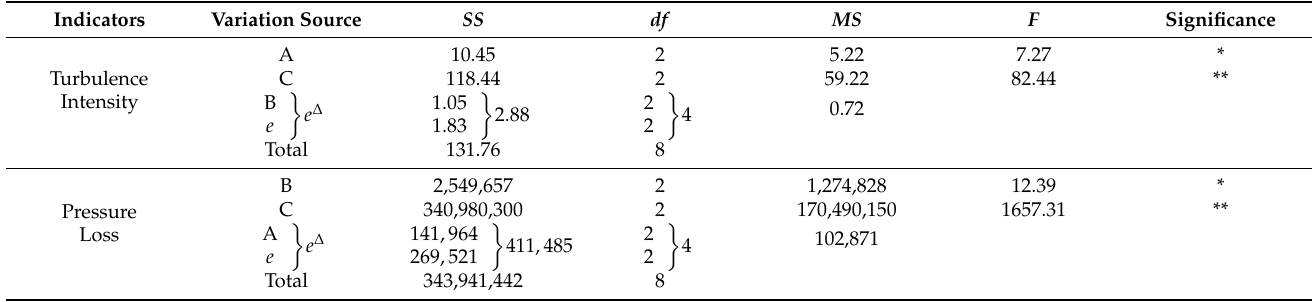
Table 7. Variance analysis